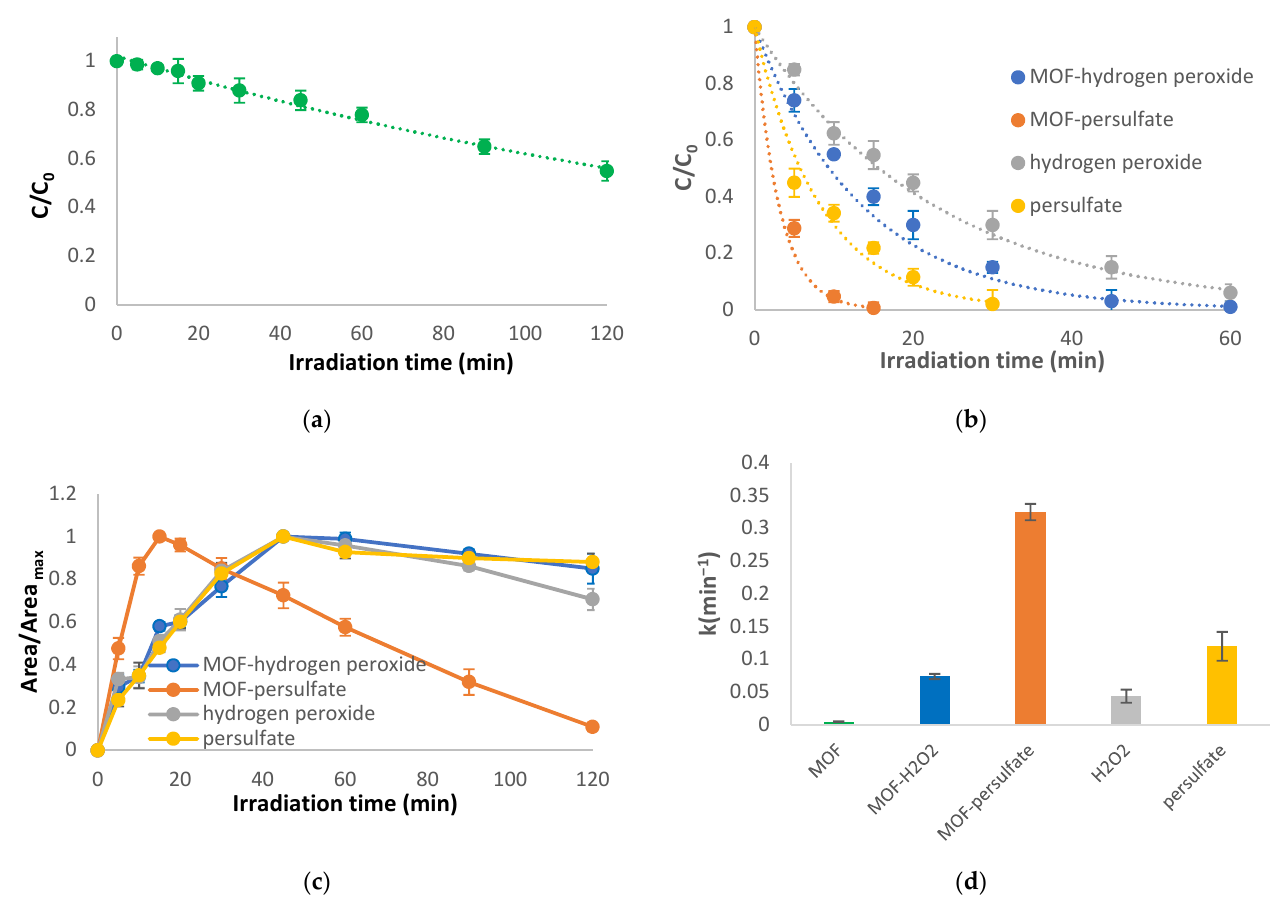
Figure 3. Photocatalytic treatment using MOF-based AOPs: ( a ) degradation of the parent compound using the UV/MOF process, ( b ) degradation of the parent compound using the UV/MOF/H 2 O 2 , UV/MOF/S 2 O 82 − , UV/H2O2, and UV/S 2 O 82 − processes, ( c ) evolution of TP-247 using the UV/MOF/H 2 O 2 , UV/MOF/S 2 O 82 − , UV/H2O2, and UV/S 2 O 82 − processes, ( d ) rate constants of the degradation of abacavir. C 0 = 10 mg/L, C MOF = 100 mg/L, C oxidant = 15 mg/L, matrix = ultrapure water.